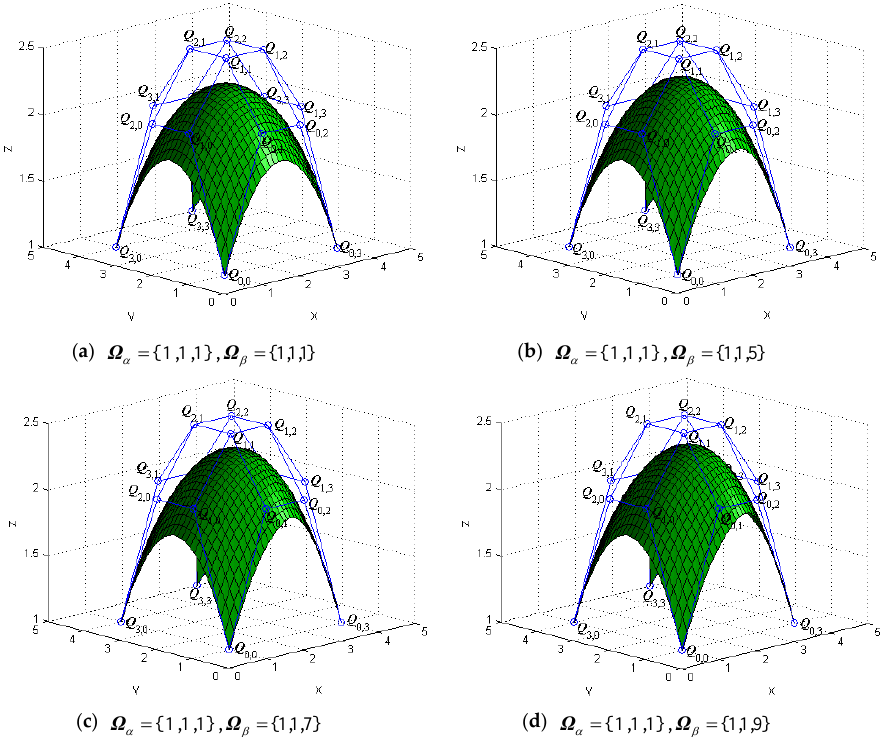
β on the generalized bicubic H-Bézier surface. Figure 5. The e ff ects of β 3 on the generalized bicubic H-B é zier 3